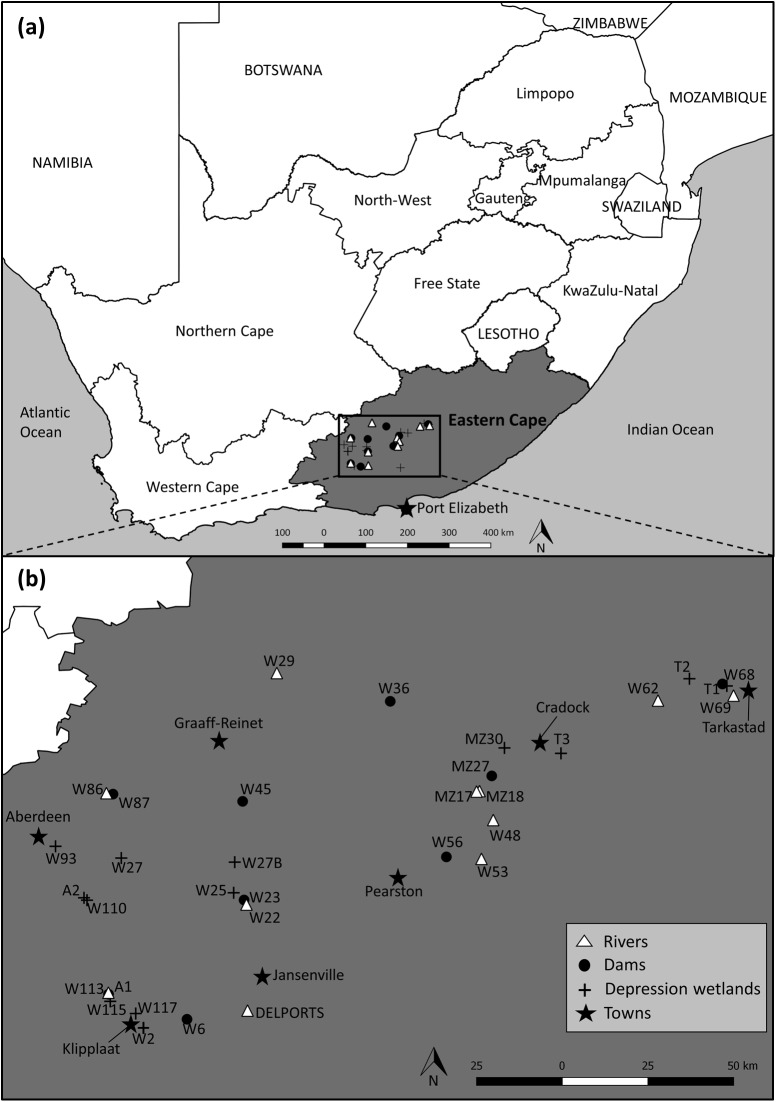
Location of sampling sites in the Eastern Cape Karoo region of South Africa.(a), and a zoomed -in perspective (b) of the 33 sites within the study area. Adapted from Mabidi et al. [39] under a CC BY license, with permission from Pensoft Publishers Ltd, original copyright 2016.